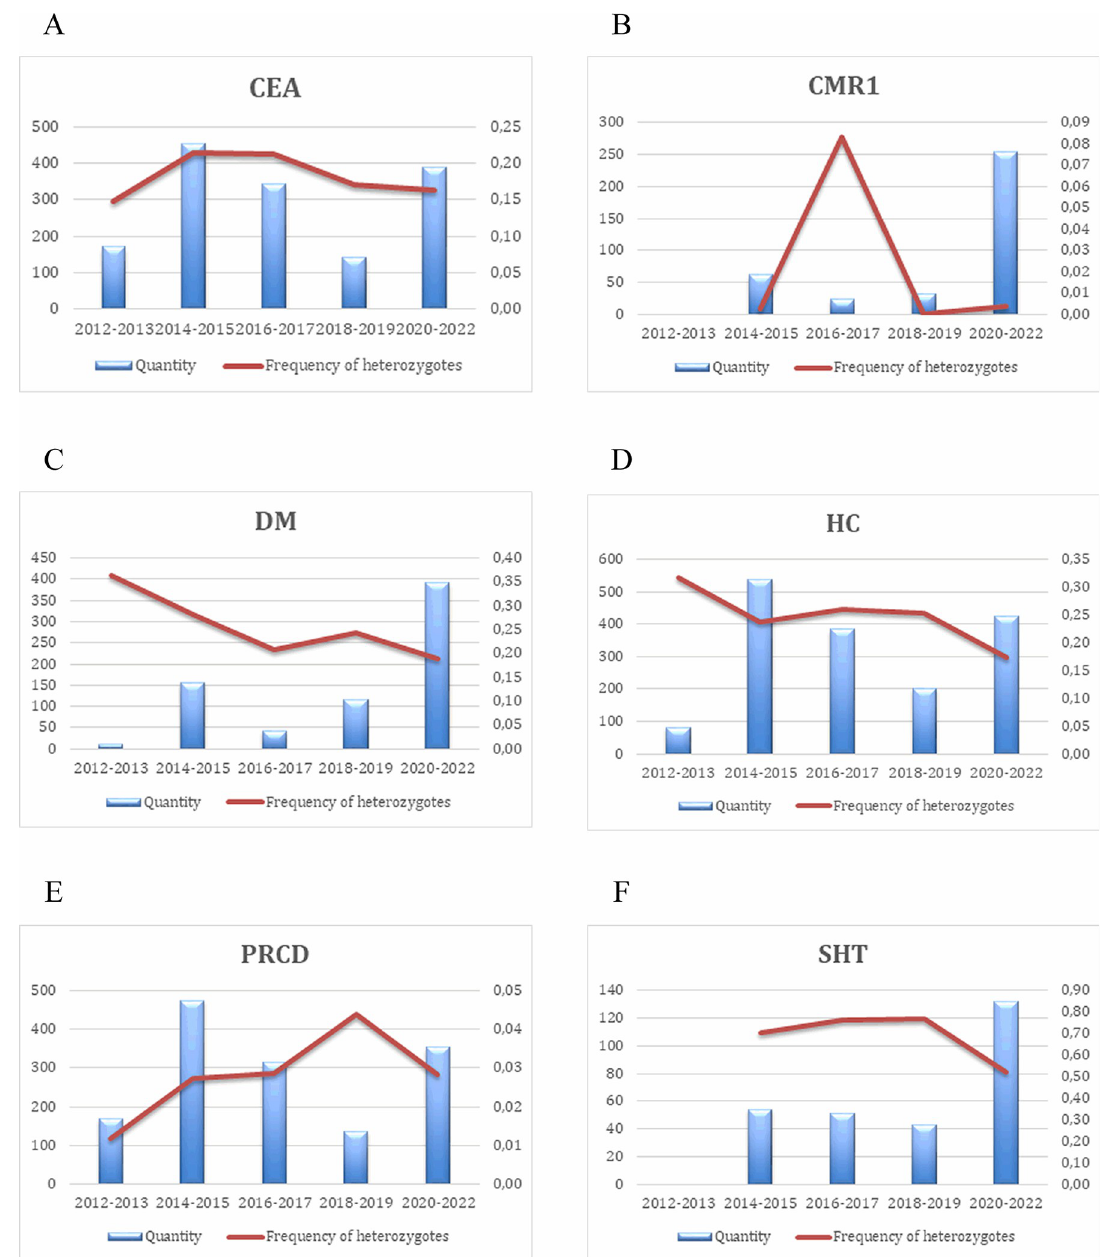
Fig 2. (A-F). The frequencies of the heterozygotes and the number of analysed samples of the six diseases in the AS breed throughout 2012–2022. Blue rectangles—number of samples over the two-year periods, orange line: the frequencies of the heterozygotes. On the other hand, the CEA frequency reported in Belgium by Beckers et al. (3.1%) was lower than in our survey (5.85%) [36]. We cannot exclude the possibility that it is just the effect of a more significant number of individuals included in our study. Little is known about the incidence of CEA mutation in non-European populations of AS. According to OFA (Ortho- paedic Foundation for Animals) statistics based on CEA test results of 128 AS from the North American population, the incidence is 1.98%, which is much lower than in Europe [37]. The